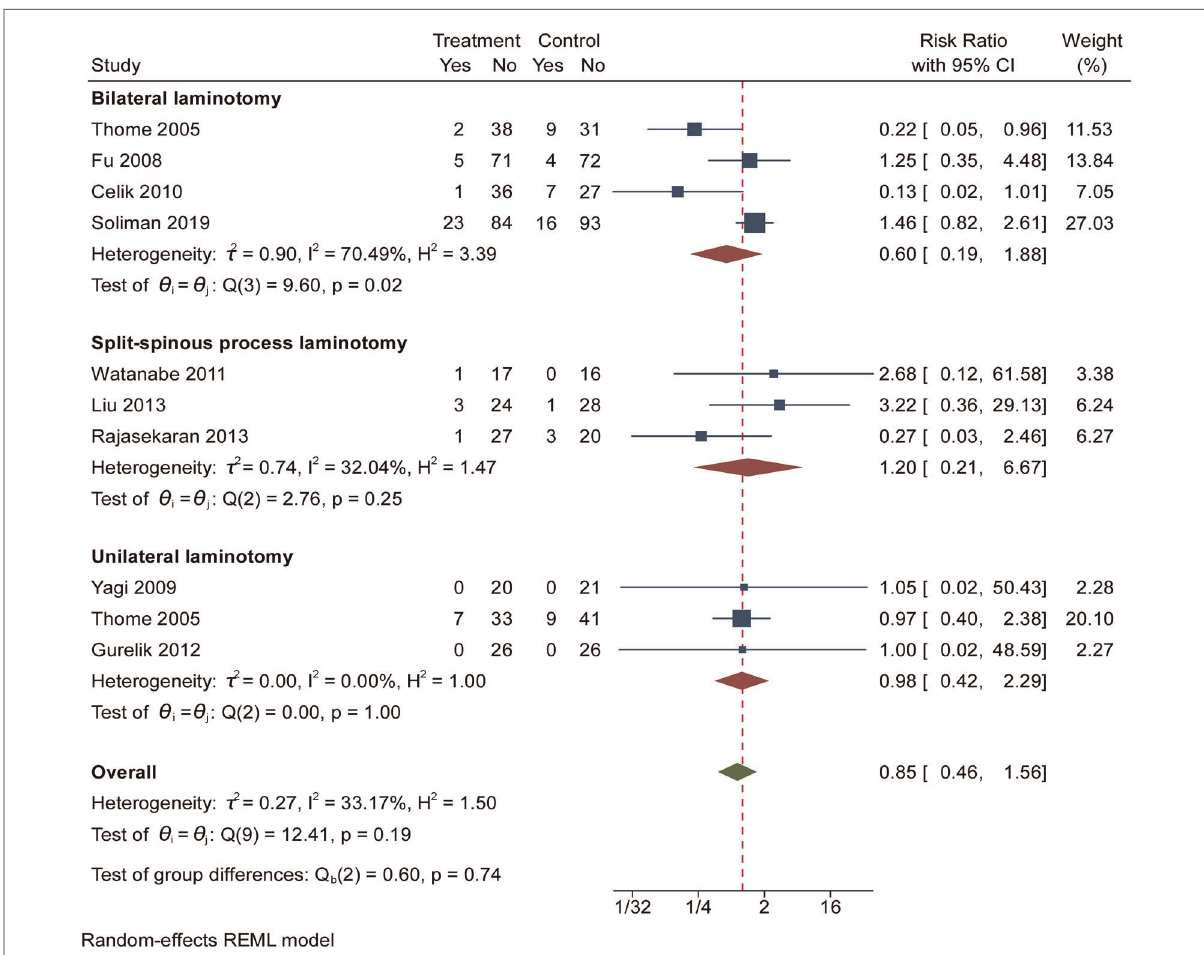
FIGURE 4 The forest plot regarding complications compared posterior techniques with tourniquet